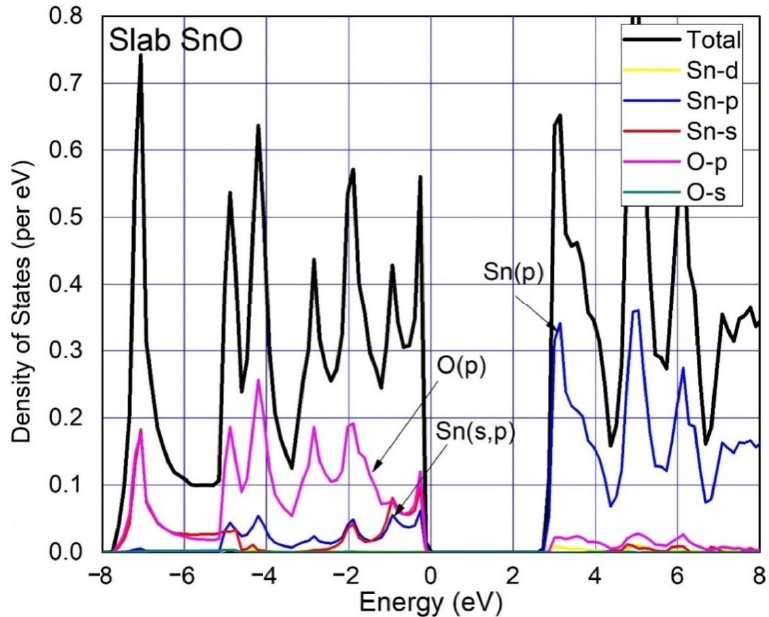
Figure 4. Total Density of States (TDOS) and Partial Density of States (PDOS) were calculated for monolayer SnO. The Fermi level is adjusted at 0 eV, whereas the colored lines represent states per mentioned labels. There is a gap of 2.85 eV between CBM and VBM.